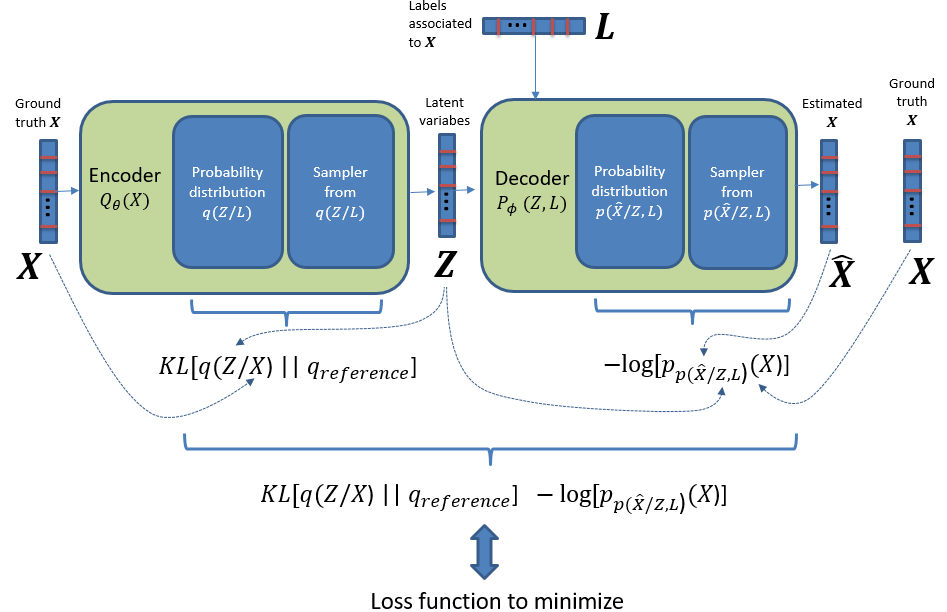
Figure 2. Details on the loss function elements for the ID-CVAE model.